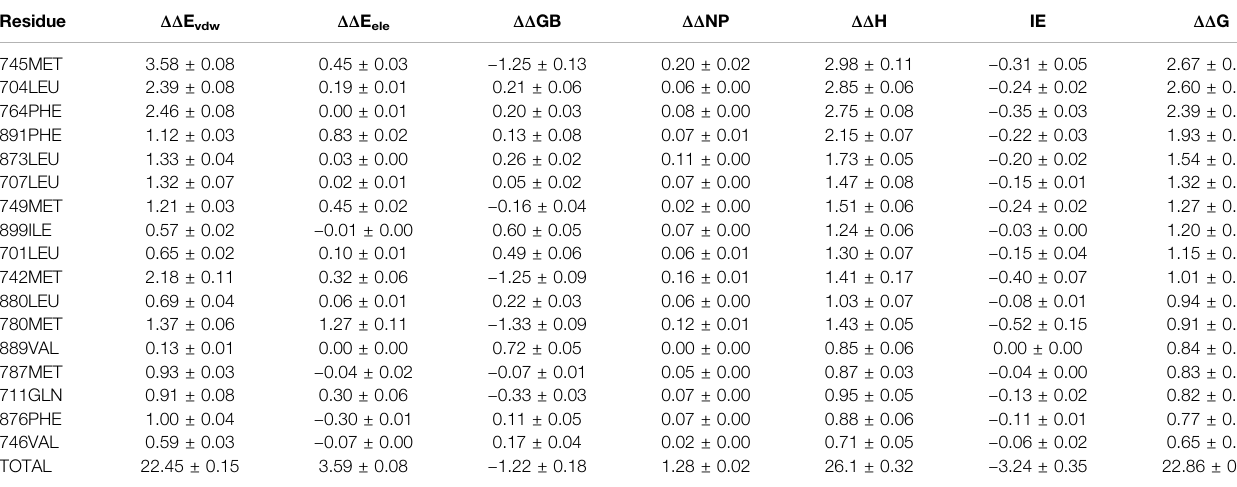
TABLE 2 | Residue-Speci fi c Binding Free Energies (kcal/mol) of 3g0w (Nirschl et al., 2009) calculated by ASIE.